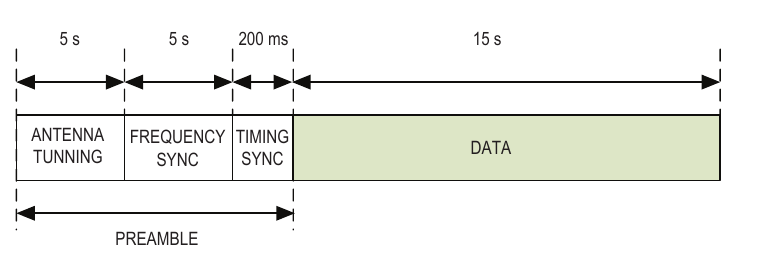
Figure 3. Transmitted